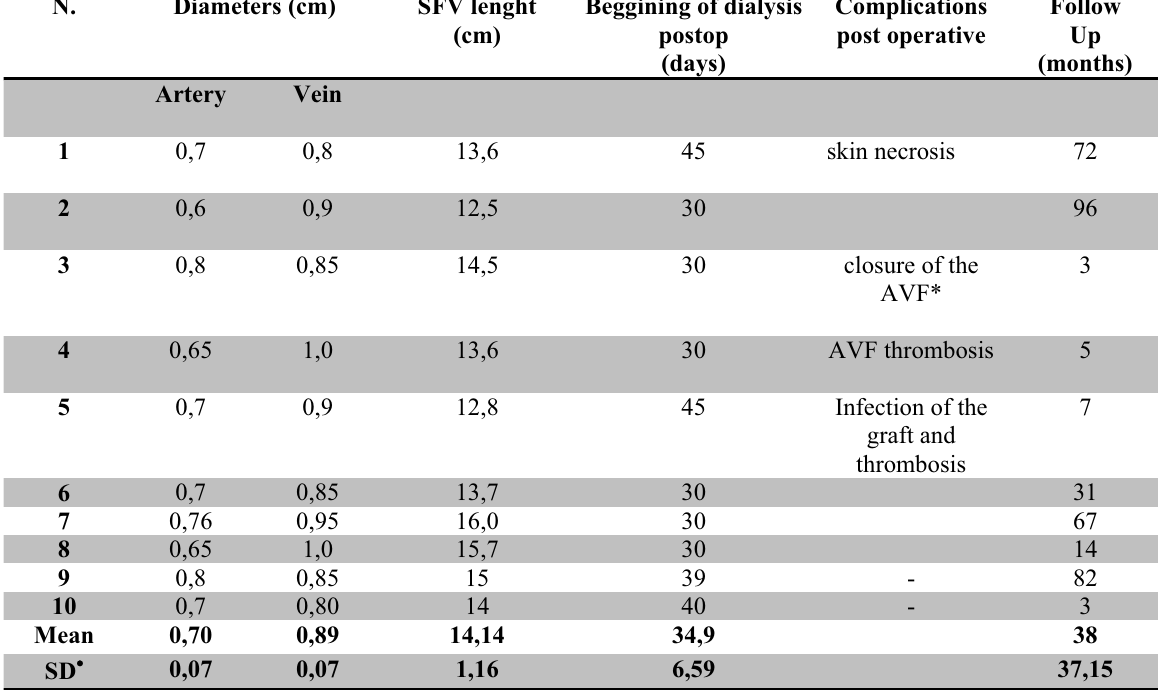
TABLE 2 – General characteristics of the patients (patient number, diameters of artery and vein, superficial femoral vein [SFV] length, beginning of dialysis post operative, complications post operative, follow up) N.